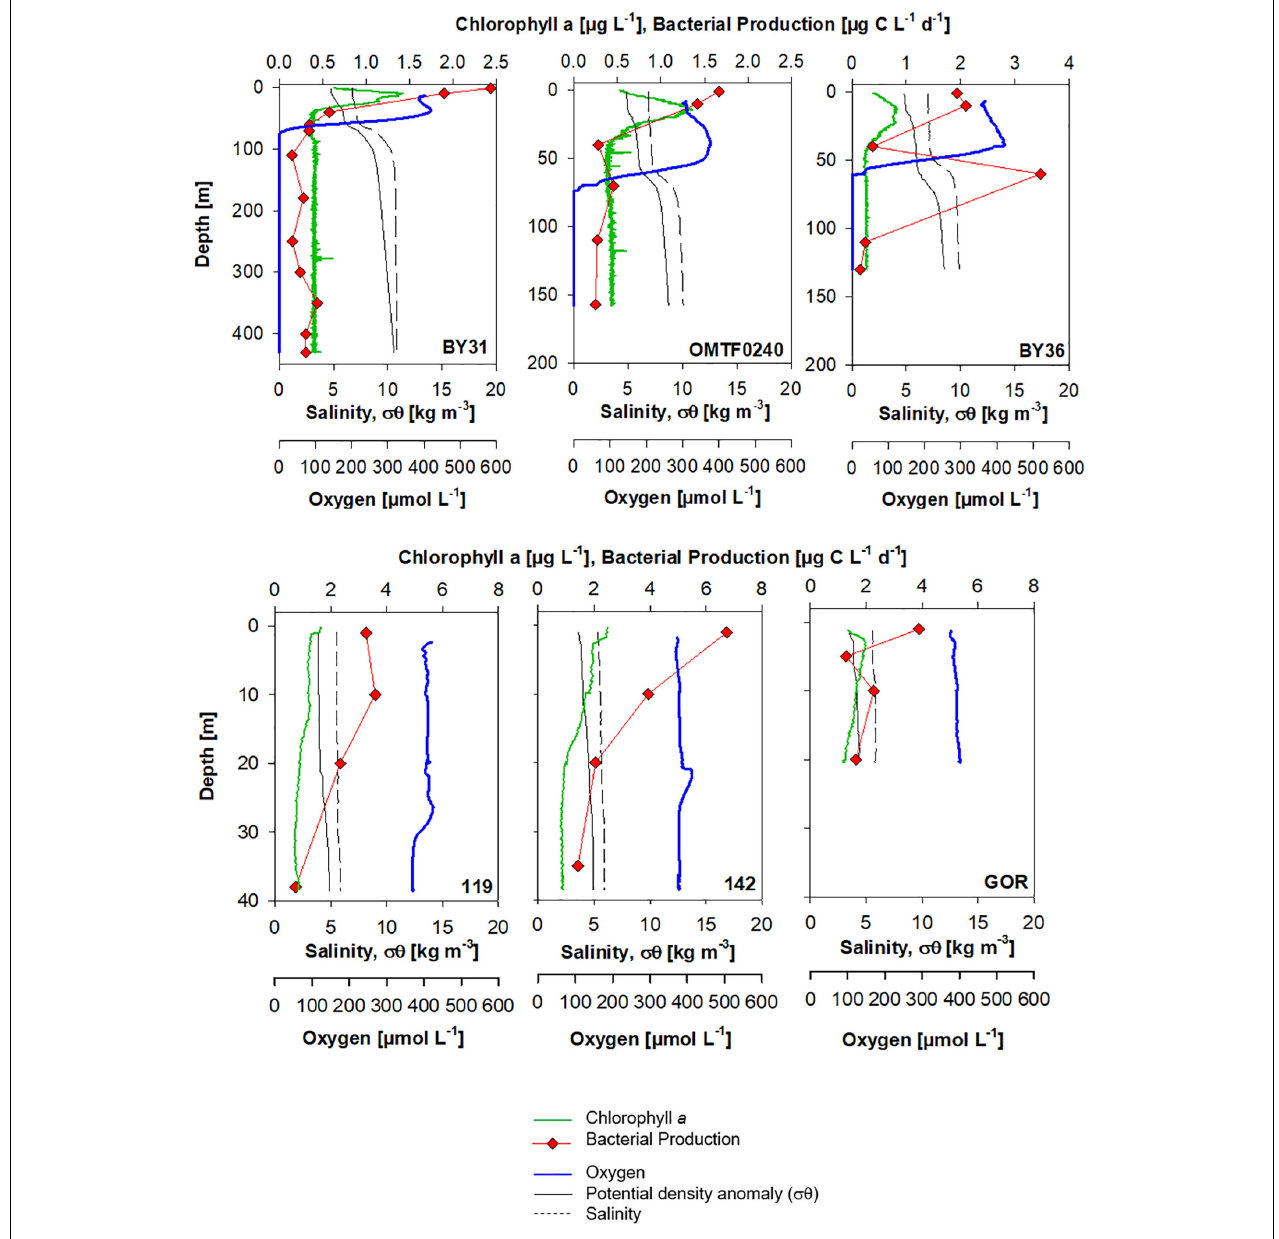
FIGURE 3 | Individual depth profiles of chlorophyll a , heterotrophic bacterial production, oxygen, salinity, and density in the Baltic Sea during June